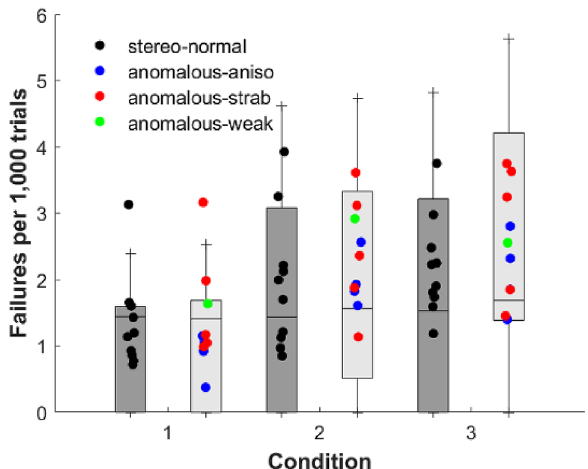
Figure 8. Box plots of Halloween game failures to detect dichoptic targets per 1,000 trials for stereo-normal (grey bars) and stereo-anomalous (white bars) groups for each Condition (1, 2 and 3). Symbols represents data from one participant: stereo-normal (black), anisometropic (blue), strabismic (red) and stereo-weak (green). The horizontal line represents the group median while the whiskers represent the interquartile